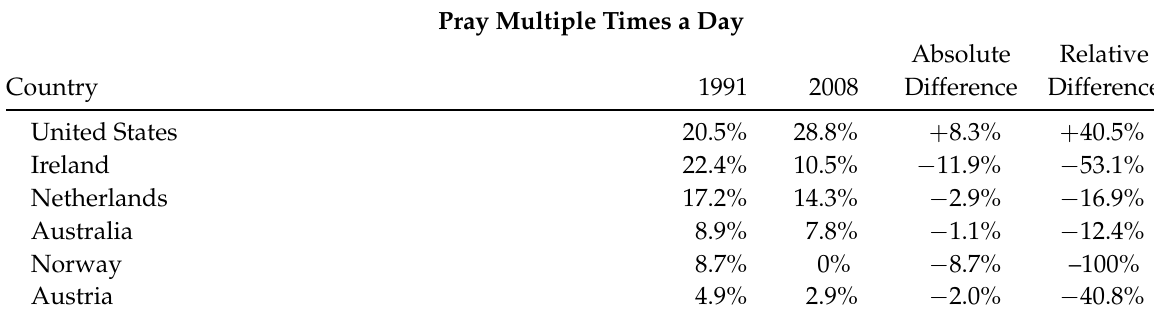
Table 1: Cross-national change in intense religion, International Social Survey